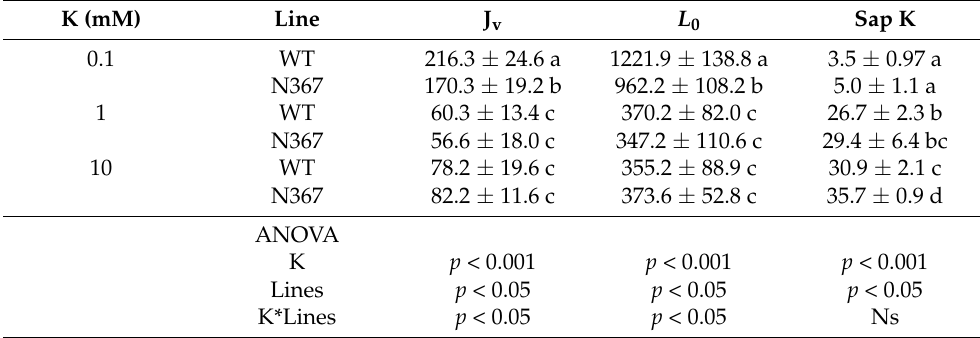
Table 7. Effect of available K on sap flow (J v ), root hydraulic conductivity (L 0 ) and xylem sap K concentration in hydroponically grown tomato lines WT and N367 at flowering stage. Means followed by the same letter are not significantly different (LSD Test, p < 0.05). K and L in ANOVA represent potassium and line factors, respectively. K (mM) Line J v L 0 Sap K 0.1 WT 216.3 ± 24.6 a 1221.9 ± 138.8 a 3.5 ± 0.97 a N367 170.3 ± 19.2 b 962.2 ± 108.2 b 5.0 ± 1.1 a 1 WT 60.3 ± 13.4 c 370.2 ± 82.0 c N367 WT ANOVA K p < 0.001 p < 0.001 p < 0.001 Lines p < 0.05 p < 0.05 p < 0.05 K*Lines p < 0.05 p < 0.05